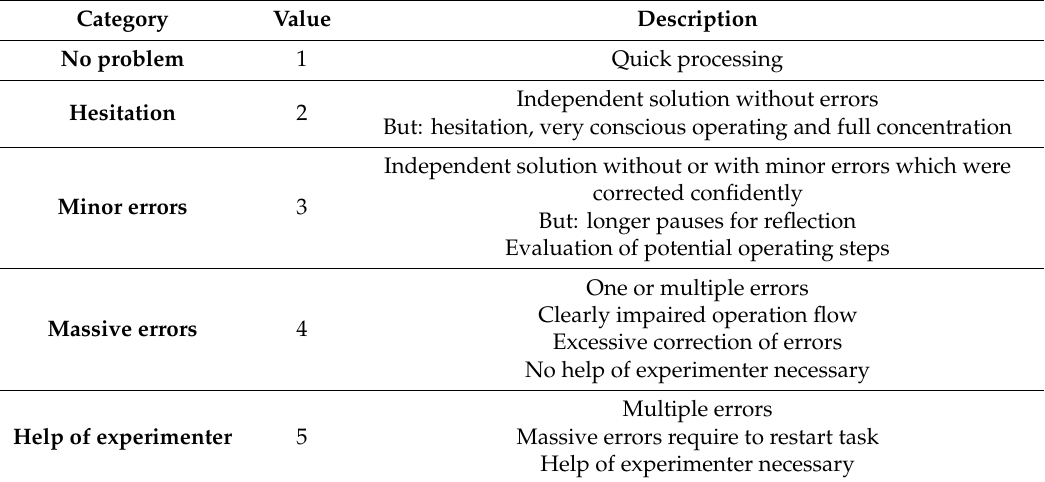
Table 1. Experimenter rating with label and